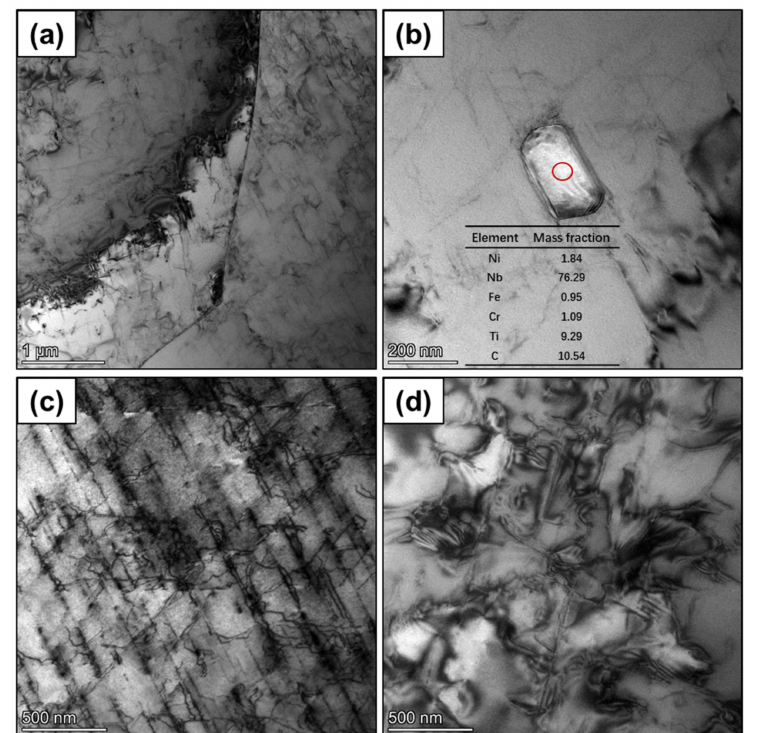
Figure 3. The bright field TEM images of the 945A-32h sample, ( a ) the grain boundaries and the dislocations, ( b ) the second phase morphology, ( c , d ) magnified images of the dislocations. Meanwhile, many nanoscale precipitates were observed in Figure 4. The size of the precipitates was 10–20 nm and the space between these precipitates was 5–10 nm. Such a high density of precipitates illustrated that a large fraction of the solid alloy was precipitated. Under the spatial axis of (220), two different direction distributions of the precipitates were found. These two directions were perpendicular to each other as marked by the yellow box. According to the literature [22], precipitates with such a microstructure in 945 Ni-based alloys are considered to be γ (cid:48) phase. The γ (cid:48) phase was precipitated on the (110) plane of the matrix. The high density of the γ (cid:48) phase is beneficial in improving the mechanical properties after aging treatment.